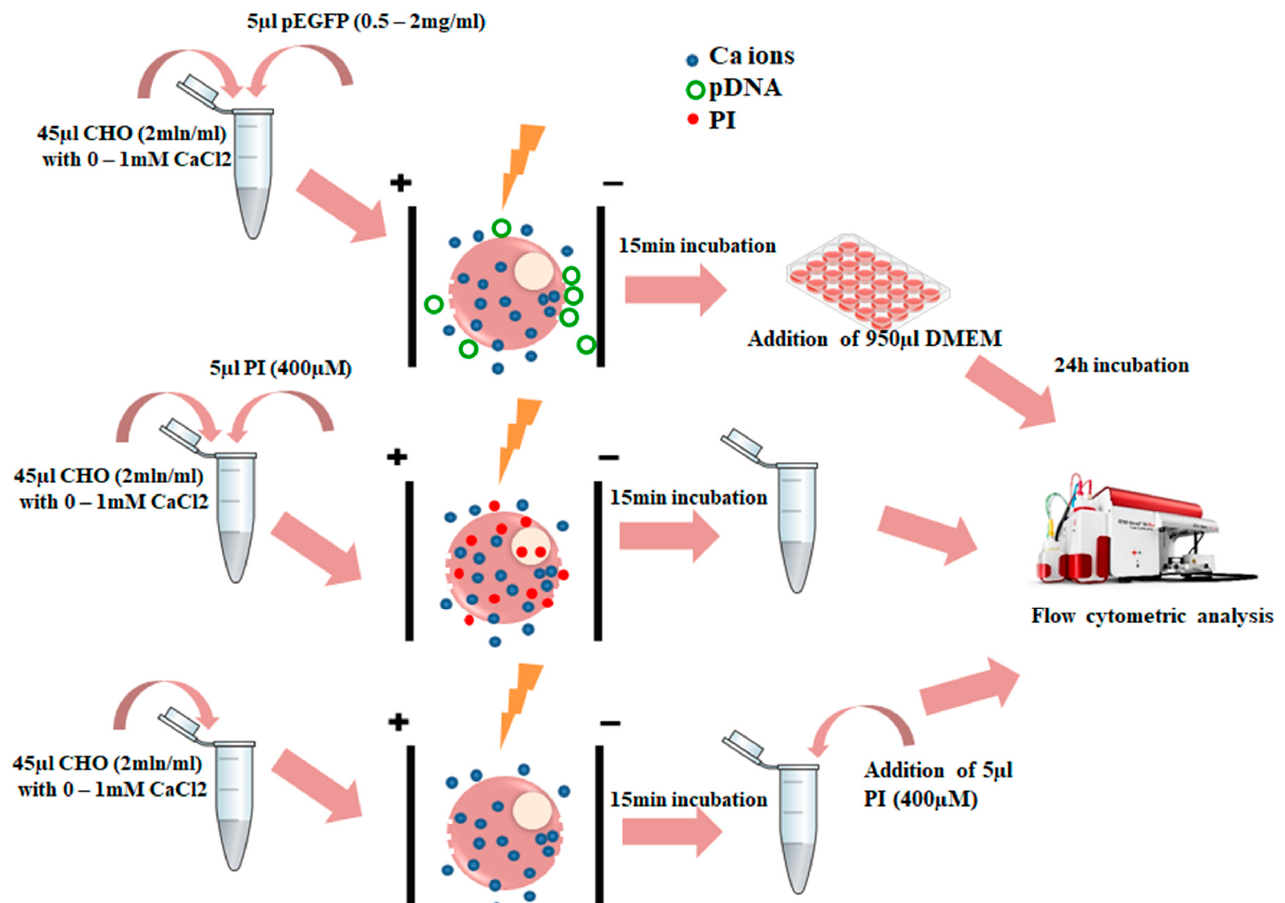
Figure 1. The principal scheme of the experiments performed in this study in order to evaluate pDNA and PI electrotransfer dynamics at different concentrations of CaCl 2 .